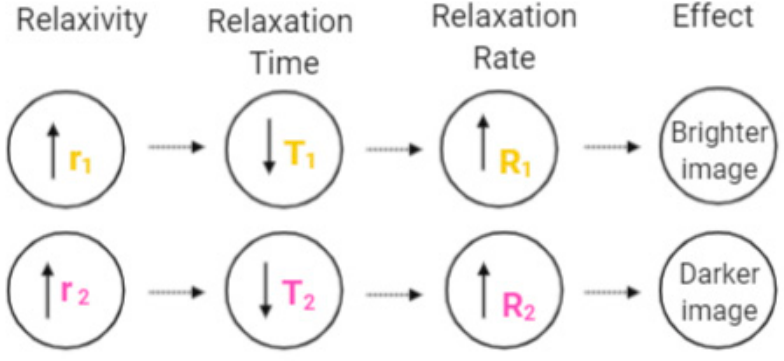
Figure 3. Effect of relaxivity, relaxation time, and relaxation rate on the MRI image.